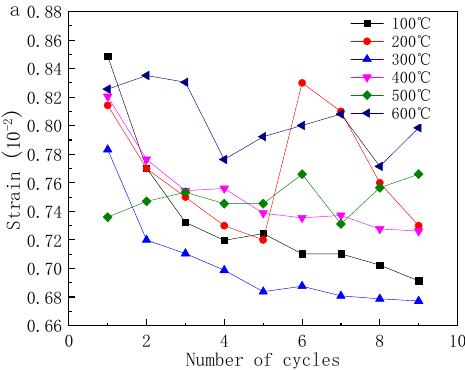
Figure 8. Variations of strain corresponding to upper loads of granite samples with number of temperature and stress cycles at six upper limit cyclic temperatures ( a ) upper limit of cyclic stress = 70% of UCS, ( b ) upper limit of cyclic stress = 85% of UCS.